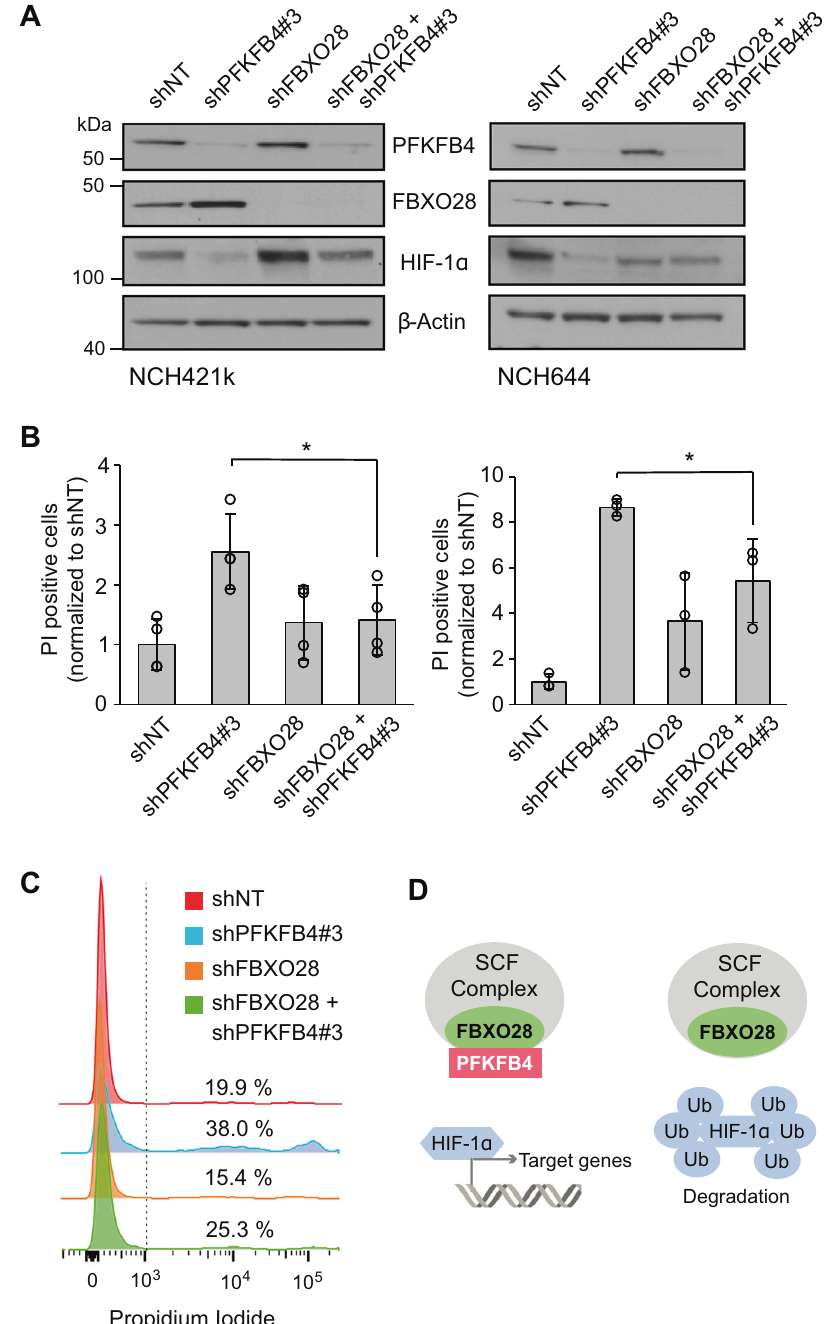
Fig. 6 HIF-1 α protein level is dependent on the interaction of PFKFB4 with FBXO28. A Protein levels of PFKFB4, FBXO28 and HIF-1 α in NCH421k and NCH644 GSCs with PFKFB4 and FBXO28 silencing (3 days) separately or together. β -actin is displayed as a loading control. B FACS analysis of propidium iodide stained NCH421k (left) and NCH644 (right) GSCs with PFKFB4 and FBXO28 silencing (4 days) separately or simultaneously. Data are normalized to cells transduced with shNT ( n = 3) and are represented as mean ± SD, two-sided t -test, * p value < 0.05. C Representative histograms of the FACS data highlighting the rescue of the phenotype upon simultaneous silencing of PFKFB4 and FBXO28. D Scheme showing the proposed mechanism of PFKFB4 and FBXO28 acting on HIF-1 α stability and therefore cell viability (Ub =